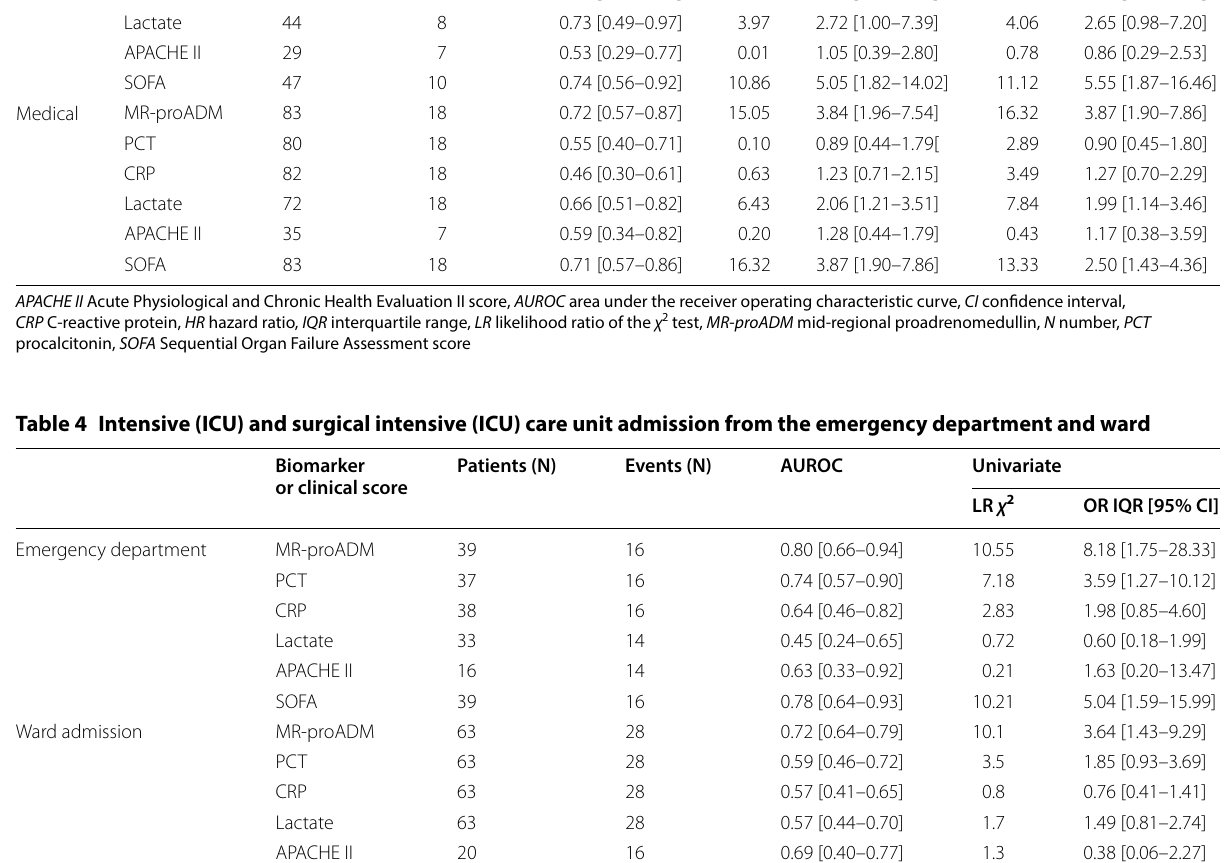
APACHE II Acute Physiological and Chronic Health Evaluation II score, AUROC area under the receiver operating characteristic curve, CI confidence interval, CRP C-reactive protein, IQR interquartile range, LR likelihood ratio of the χ 2 test, MR - proADM mid-regional proadrenomedullin, N number, OR odds ratio, PCT procalcitonin, SOFA Sequential Organ Failure Assessment